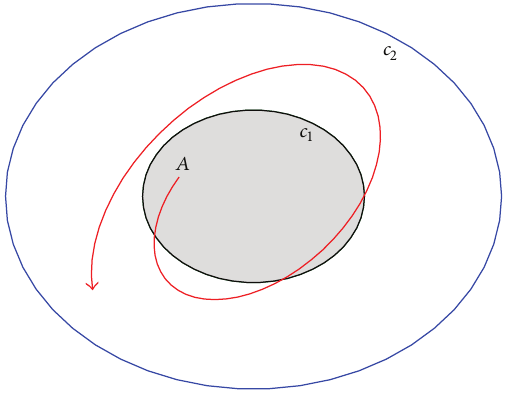
Figure 2: Illustration of finite-time stability in